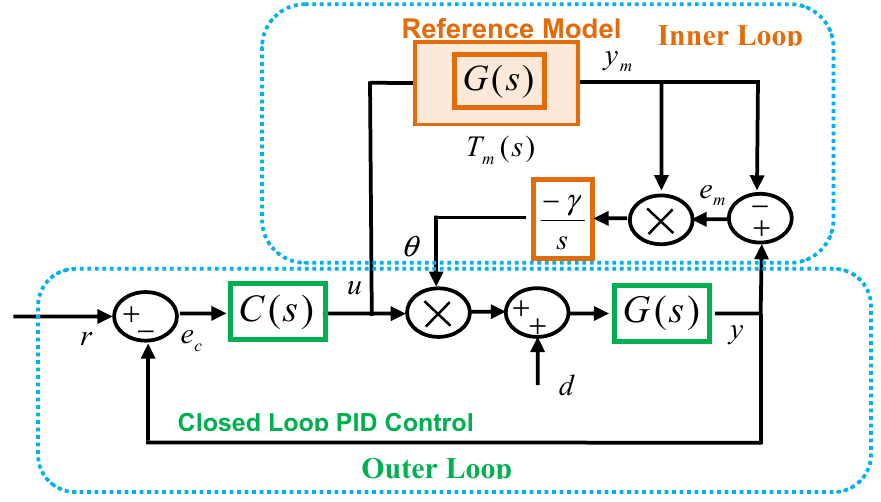
Figure 15. Block diagram of the ML-MR MIT-PID-PFA control structure.